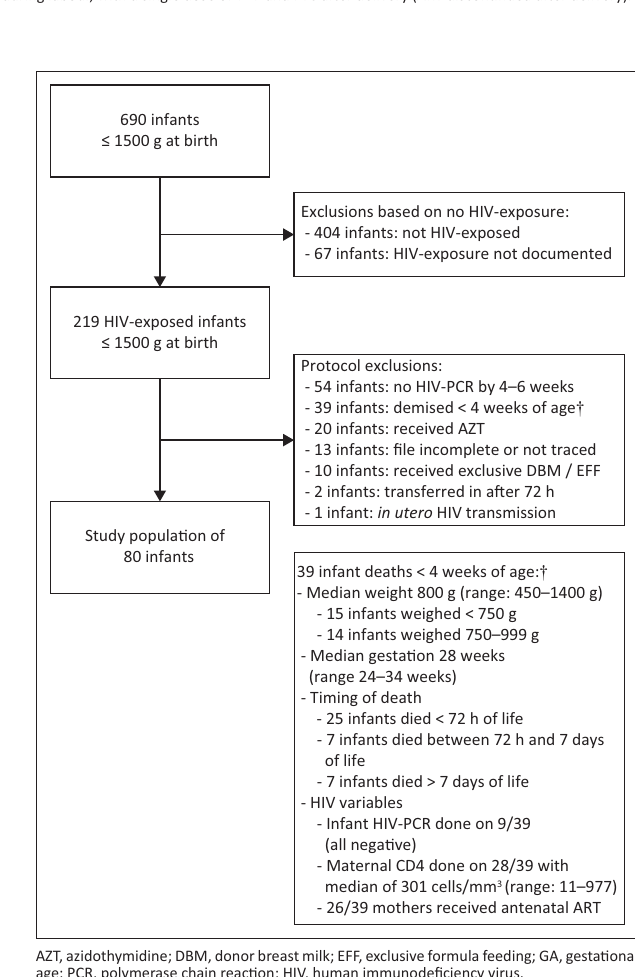
FIGURE 1: Flow chart detailing exclusions.